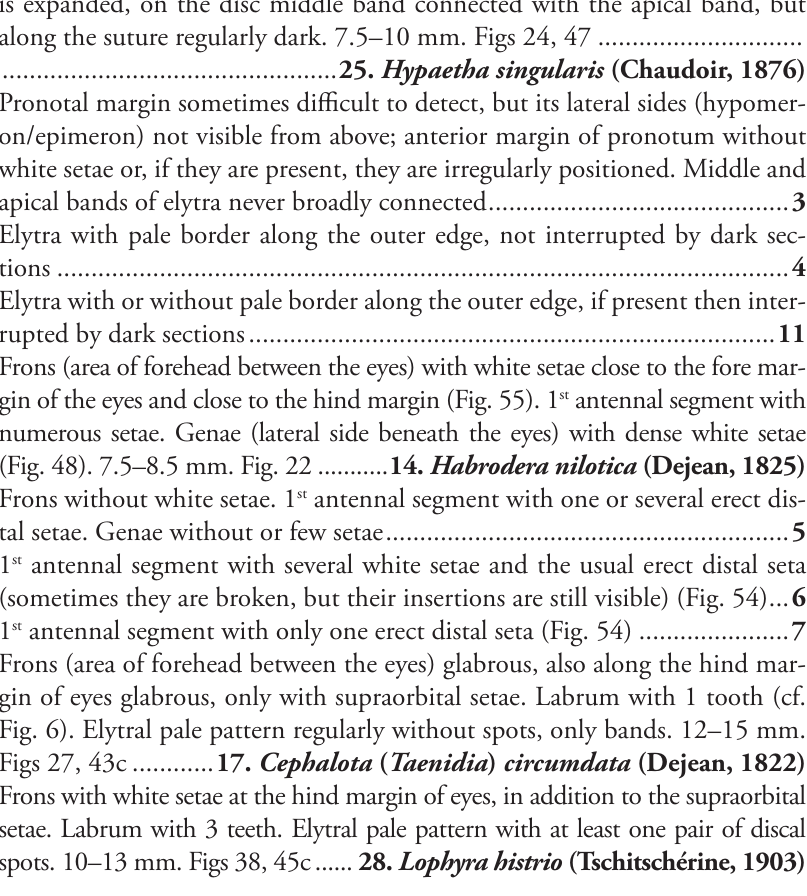
Peninsula), and thus their occurrence in the southern Levant is unlikely. In many cases, the photographs from Werner (1991; 1992) may be sufficient to identify these species. 1 Larger (19–26 mm). Scutellum not visible in commonly mounted beetles, not triangular. Side margin of pronotum with a forward projecting lobe. Last segment of maxillary palpi shorter than penultimate one. Elytra green (rarely blue or black) with a pale apical spot. Fig. 7 ...... 1. Grammognatha euphratica (Dejean, 1822) – Smaller (less than 18 mm). Scutellum clearly visible and triangular. Side margin of pronotum weakly developed, without a forward projecting lobe. Penultimate segment of maxillary palpi as long as the last one or shorter. Coloration different, if green then with more than 1 pale spot .................... 2 2 Pronotal margin clearly visible on upper side of prothorax, its lateral sides (hypomeron/epimeron) visible from above; anterior margin of pronotum with a dense and regular series of white setae (Fig. 55). Pale pattern of elytra is expanded, on the disc middle band connected with the apical band, but along the suture regularly dark. 7.5–10 mm. Figs 24, 47 .............................. ................................................. 25. Hypaetha singularis (Chaudoir, 1876) – Pronotal margin sometimes difficult to detect, but its lateral sides (hypomer- on/epimeron) not visible from above; anterior margin of pronotum without white setae or, if they are present, they are irregularly positioned. Middle and apical bands of elytra never broadly connected ............................................ 3 3 Elytra with pale border along the outer edge, not interrupted by dark sec- tions ........................................................................................................... 4 – Elytra with or without pale border along the outer edge, if present then inter- rupted by dark sections ............................................................................. 11 4 Frons (area of forehead between the eyes) with white setae close to the fore mar- gin of the eyes and close to the hind margin (Fig. 55). 1 st antennal segment with numerous setae. Genae (lateral side beneath the eyes) with dense white setae (Fig. 48). 7.5–8.5 mm. Fig. 22 ........... 14. Habrodera nilotica (Dejean, 1825) – Frons without white setae. 1 st antennal segment with one or several erect dis- tal setae. Genae without or few setae ........................................................... 5 5 1 st antennal segment with several white setae and the usual erect distal seta (sometimes they are broken, but their insertions are still visible) (Fig. 54) ... 6 – 1 st antennal segment with only one erect distal seta (Fig. 54) ...................... 7 6 Frons (area of forehead between the eyes) glabrous, also along the hind mar- gin of eyes glabrous, only with supraorbital setae. Labrum with 1 tooth (cf. Fig. 6). Elytral pale pattern regularly without spots, only bands. 12–15 mm. Figs 27, 43c ............ 17. Cephalota ( Taenidia ) circumdata (Dejean, 1822) – Frons with white setae at the hind margin of eyes, in addition to the supraorbital setae. Labrum with 3 teeth. Elytral pale pattern with at least one pair of discal spots. 10–13 mm. Figs 38, 45c ...... 28. Lophyra histrio (Tschitschérine,